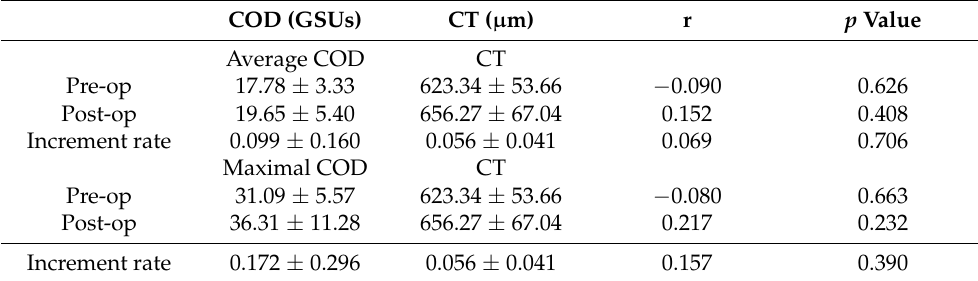
Figure 5. Correlation between the change in corneal optical density and the change in corneal thickness after cataract surgery. The delta value of corneal optical density and corneal thickness at ( a ) the annulus 0.0 to 2.0 mm, ( b ) the annulus 2.0 to 6.0 mm, and ( c ) the annulus 6.0 to 10.0 mm, ( d ) the incisional site. COD = corneal optical density; CT = corneal thickness. Table 2. Correlations between corneal optical density and corneal thickness at the incisional